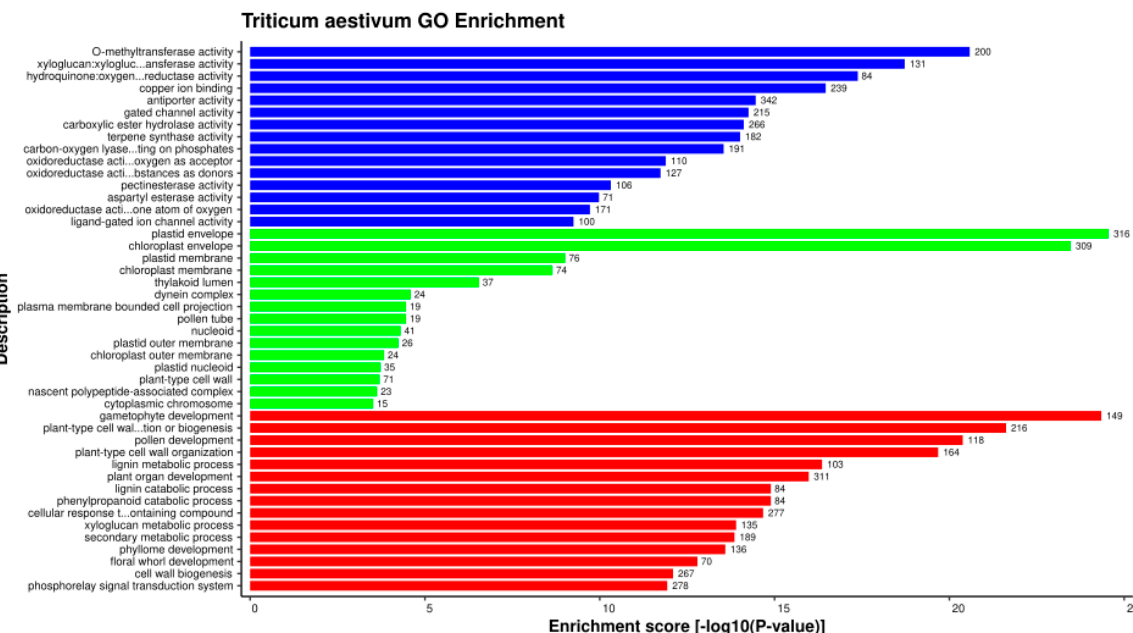
Figure 2. Over-representation of the top 15 GO terms (from each GO category) of host proteins based on enrichment score showing molecular function (blue), cellular component (green), and biological process (red).